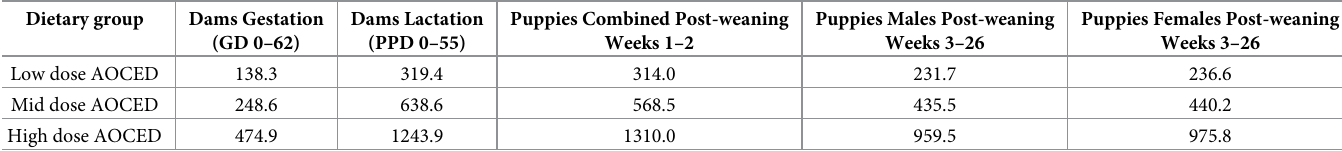
Values represent average daily AOCED intake over a period (mg/kg body